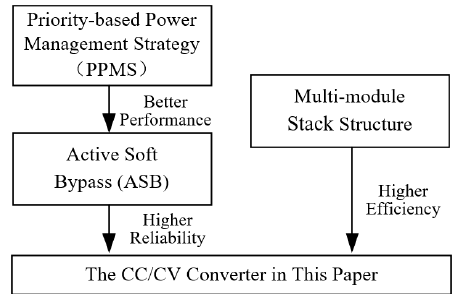
Figure 3. The relationship among the active soft bypass (ASB) technology, the priority-based power management strategy (PPMS), the multi-module-stack structure, and the proposed CC/CV converter.